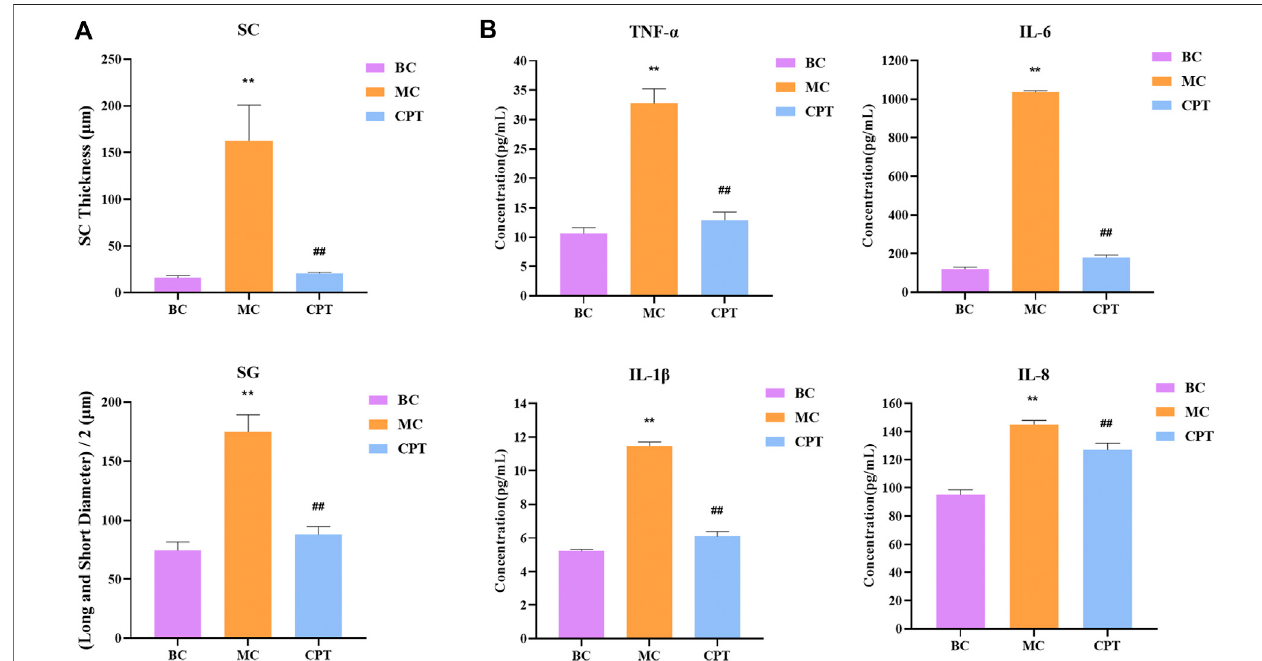
FIGURE 2 | (A) Bar graph of stratum corneum (SC) thickness and half of long diameter and short diameter of sebaceous glands (SG); original magni fi cation, × 200 (B) Cytokine levels in serum of IL-6, IL-8, TNF- α and IL-1 β in the BC, MC and CPT groups. ** , p < 0.01, compared with the BC group; ## , p < 0.01, compared with the CPT